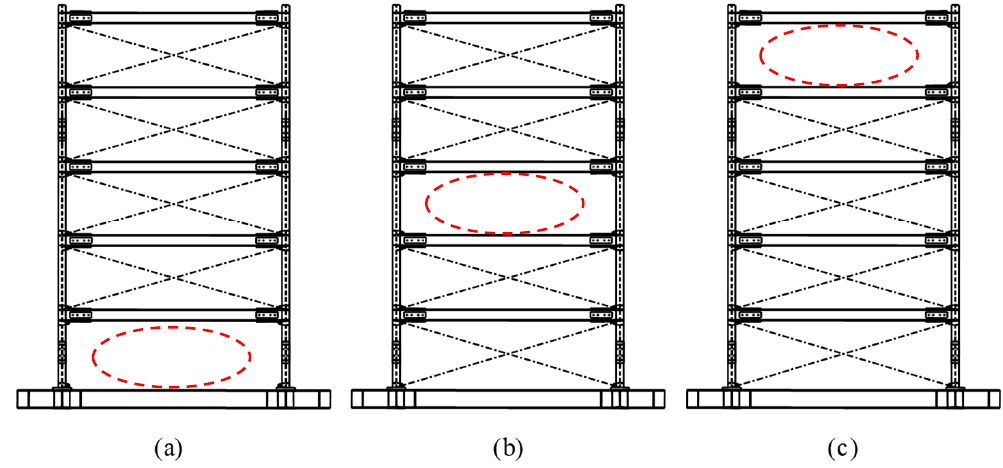
Figure 22. Acceleration time histories of the large ‐ scale framework model excited by a shaking table.